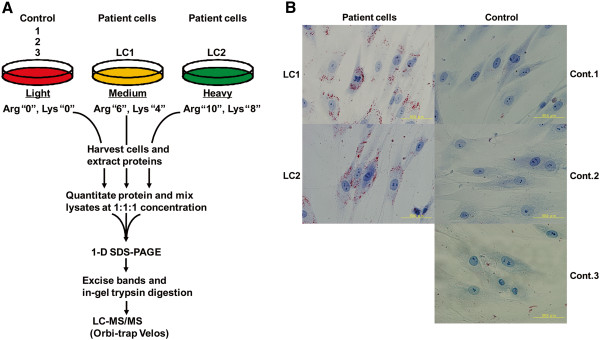
SILAC-based quantitative proteomics. (A) Flowchart of triple SILAC coupled with LC-MS/MS for the comparative analysis of three distinct cell populations. (B) Oil Red O staining of SILAC-labeled skin fibroblast cells derived from TGCV patients and healthy volunteers (controls). Characters on left and right sides of panels indicate names of patient and control cells, respectively.